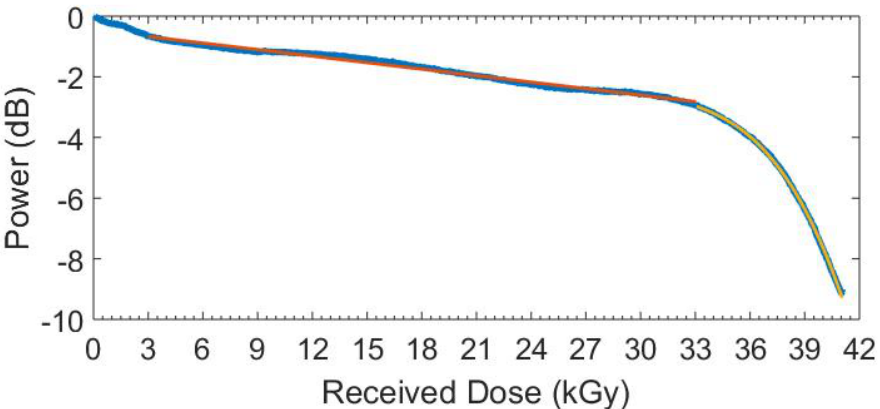
Figure 5. Amplitude degradation of the Bragg wavelength in CYTOP (blue), linear fit for first section (red) and cubic fit for the second section (yellow).